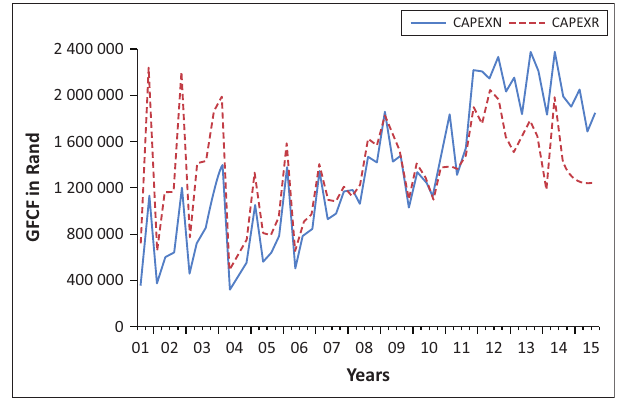
FIGURE 4: Nominal and real provincial government total capital formation